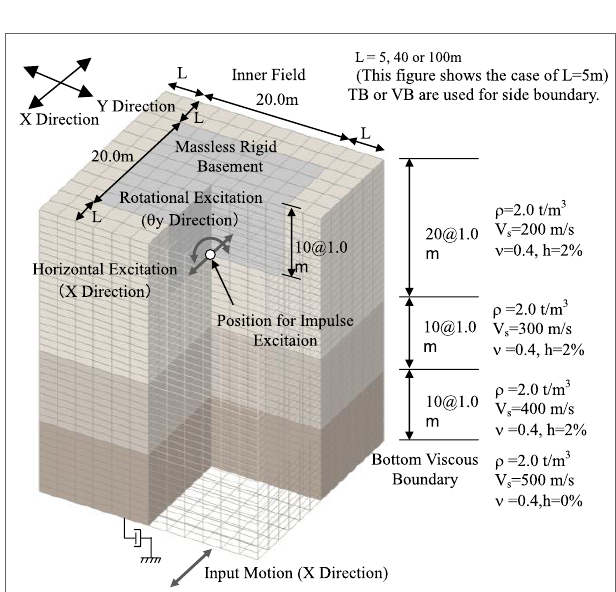
TaBle 4 | conditions for transform into the time domain.